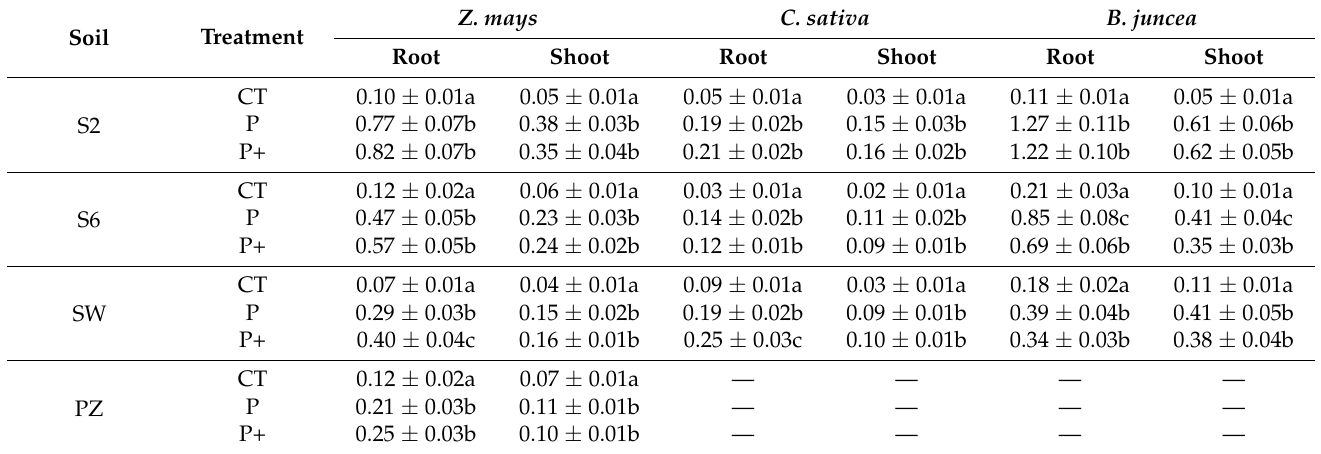
Table 3. Arsenic concentration (mg kg − 1 ) in the roots and shoots of Z. mays, C. sativa, and B. juncea grown on control (CT) and As-contaminated soil treated with phosphate (P). The addition of PGPR bacteria (first set of isolates) is indicated with the “+” sign. Values are reported as mean ( n = 3) ± SD. Values with different letters are significantly different at the 5% probability level (Tukey’s test).